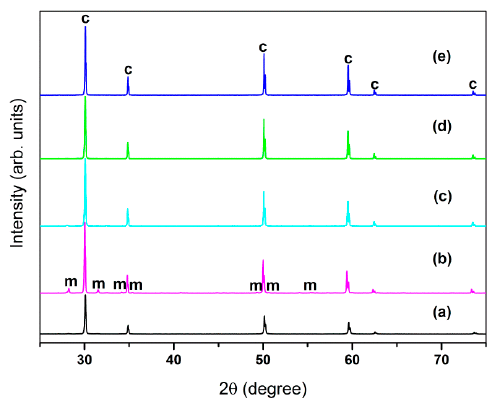
10YSZ sintered at 1550 °C, and shows that once the sintering temperature exceeds 1300 °C, 2Bi-10YSZ no longer contains the monoclinic ZrO 2 ; these results were also verified via selected area electron diffraction analysis.